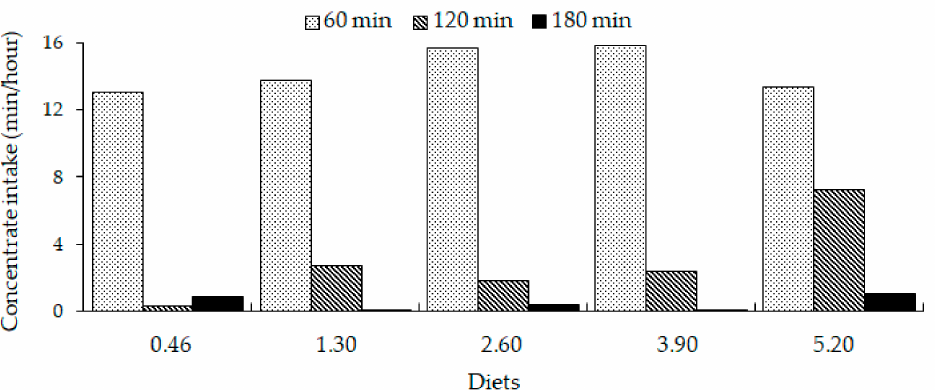
Figure 1. Time spent for concentrate intake by lactating dairy cows during each of the first 3 h (that is, the 1-h intervals ending 60, 120, and 180 min) after the offer of